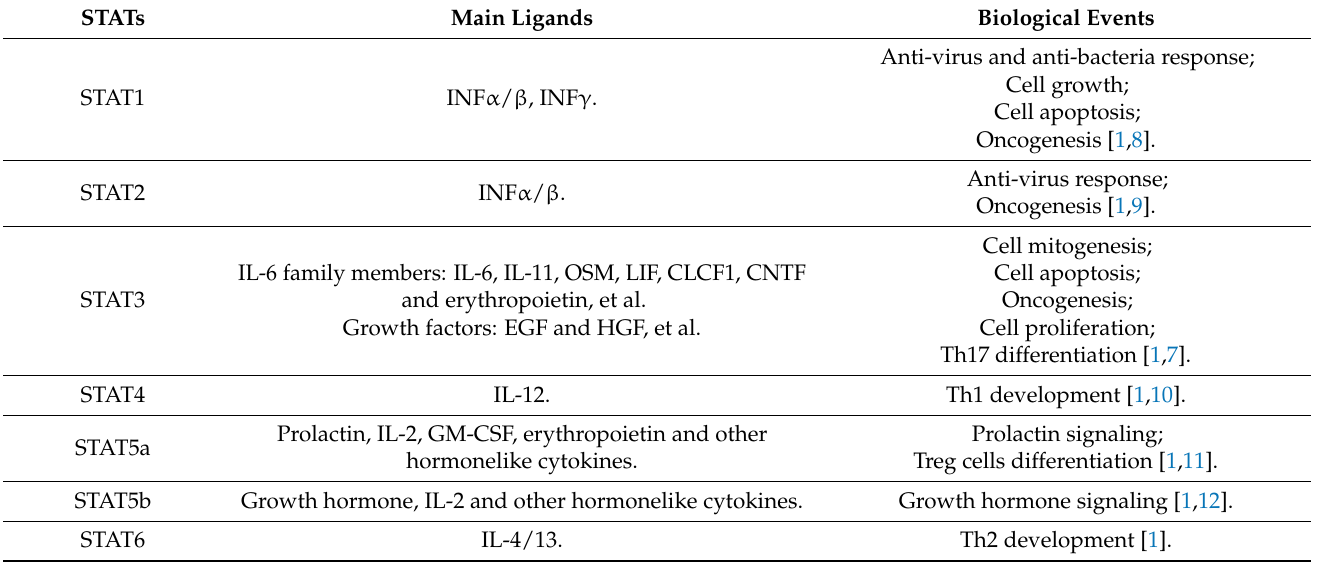
Table 1. Main ligands and modulated biological events of